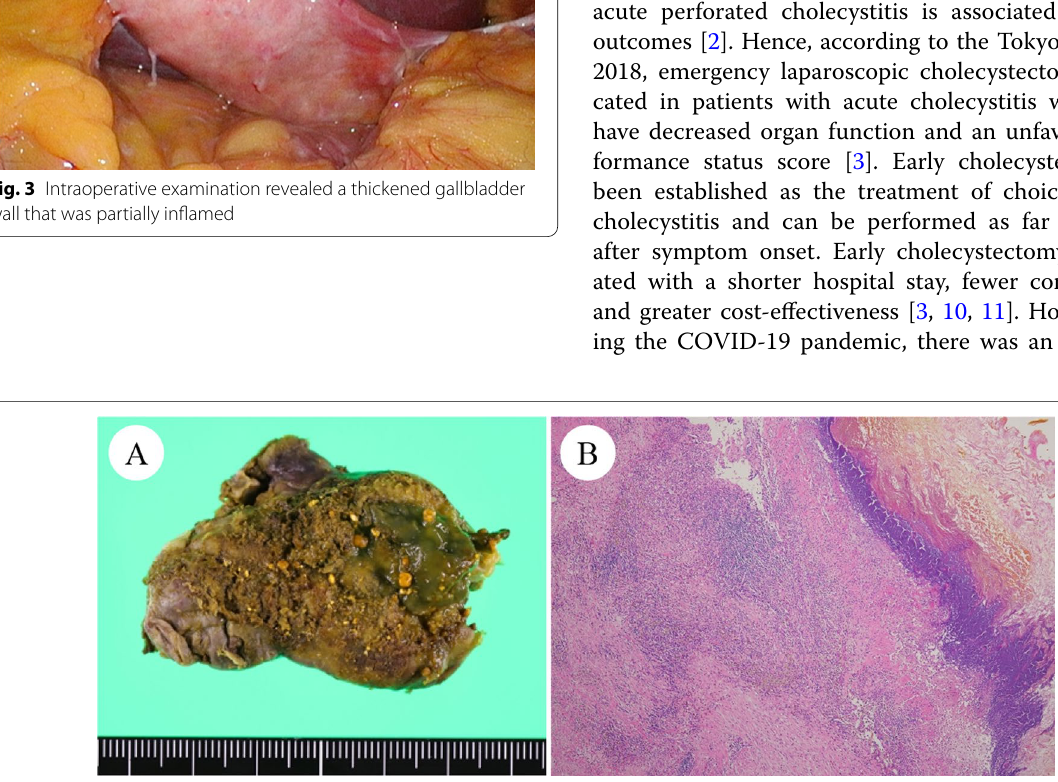
Fig. 4 Macroscopically, diffuse mucosal necrosis was observed in the gallbladder fundus ( A ). Microscopic findings showed transmural ischemic necrosis of the gallbladder fundus ( B